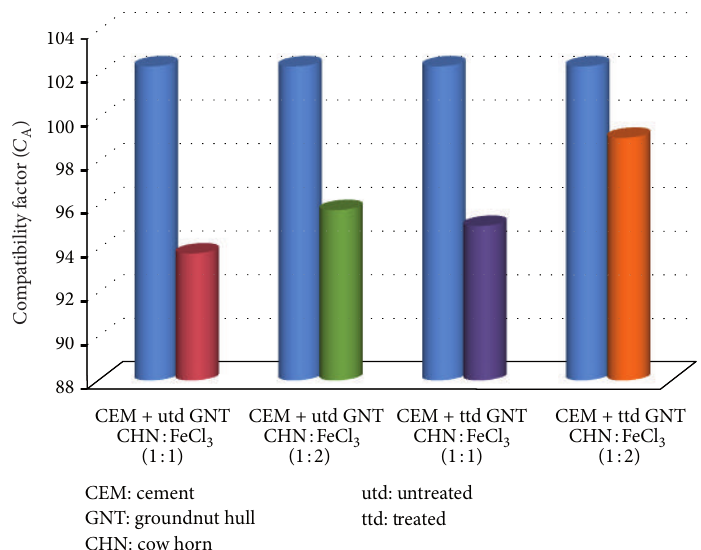
and cow horn mixture at different ratios on the compatibility factors of the cement and groundnut hull